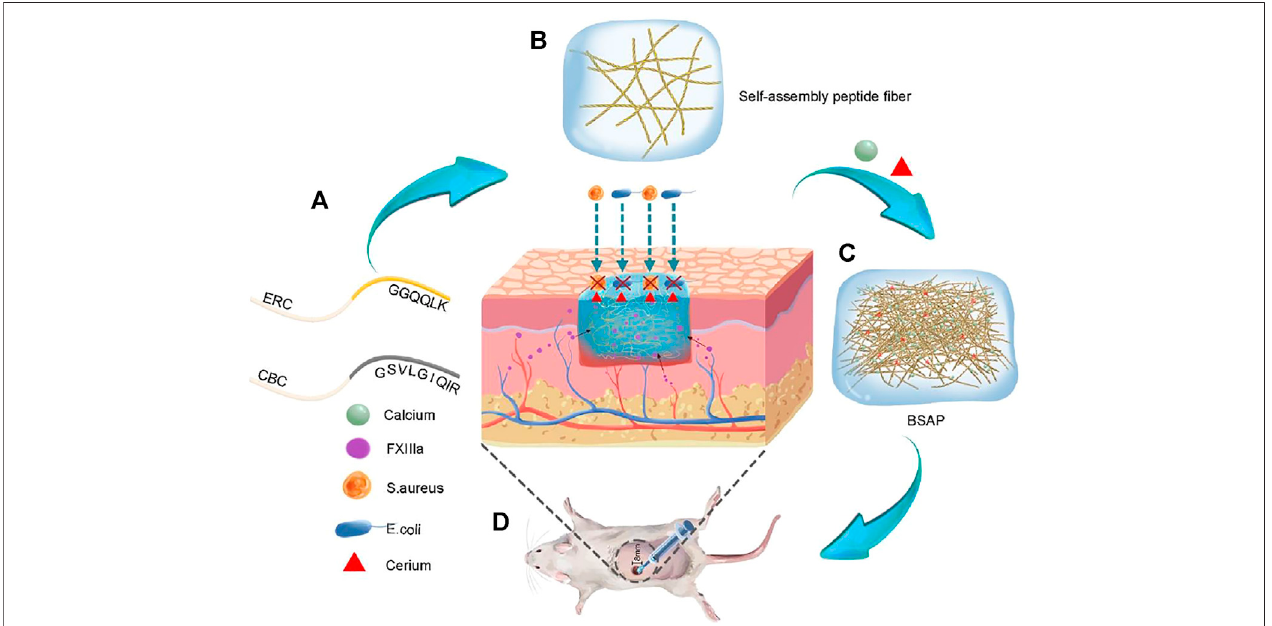
FIGURE 1 | Schematic representation formation process and function of Bionic Self-Assembling Peptide (BSAP). (A) The structure diagram of the peptide chain: calcium banding chain (CBC) and enzyme-reaction chain (ERC). (B) The sparsely wired nano fi bers formed by the conjugation of (RADA) 4 backbone. (C) The BSAP hydrogel withtightlyentangled mesh-like nano fi ber networkthatwasformed bythe functional motifs ofCBC inresponsetocalcium. Thecalcium and rareearth element cerium were bound on the nano fi ber. (D) The function schematic diagram of BSAP in wound: hemostasis and antibacterial.